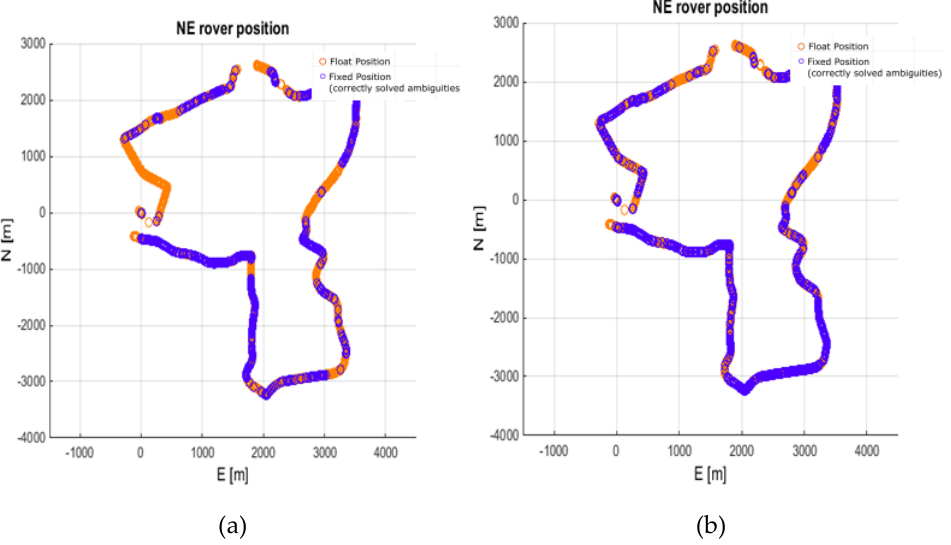
Figure 9. Rover trajectory from processing 62 km baseline (DZIA). ( a ) No ionospheric corrections; ( b ) With ionospheric corrections.